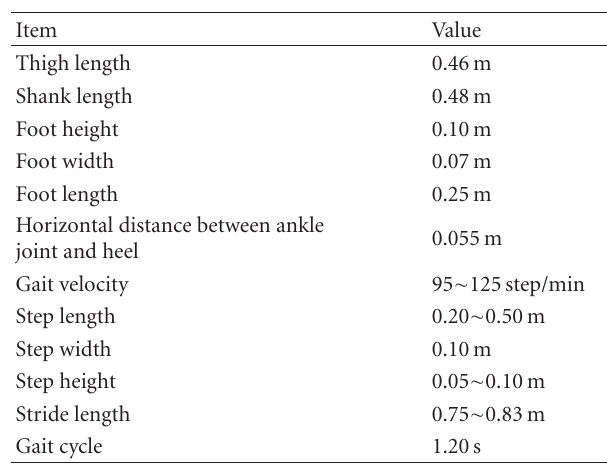
Figure 6: Ideal ZMP trajectories. Table 2: Gait parameters of